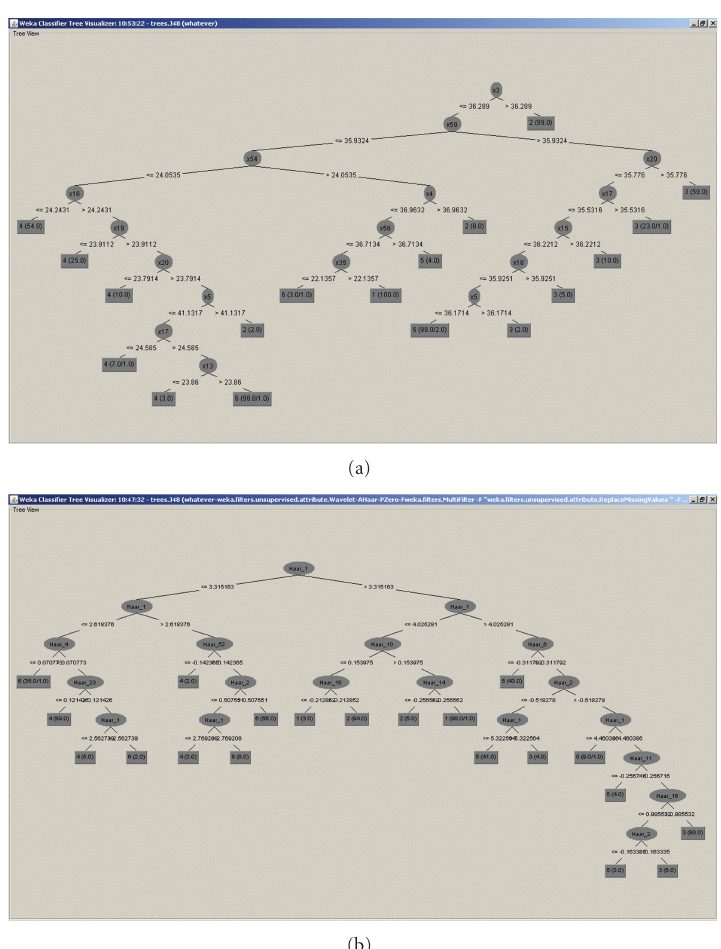
Figure 10: Snapshots of a decision tree as a result of building a classifier by (a) using the original time series, and (b) using the transformed